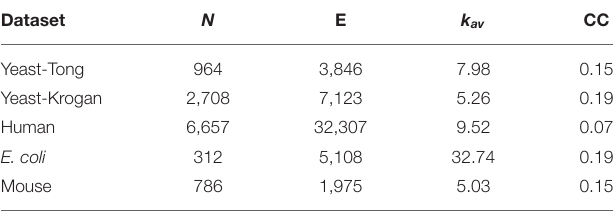
TABLE 1 | Statistics of PPI networks used in the experiments.